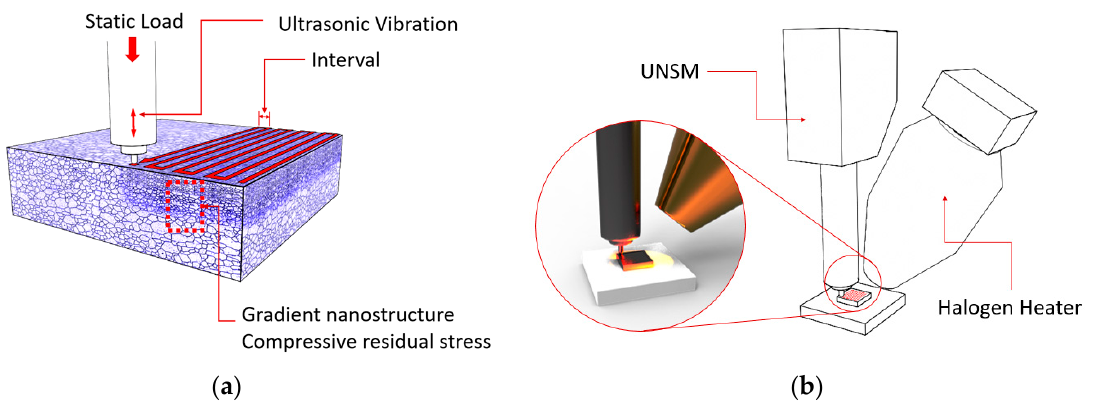
Figure 2. An illustration ultrasonic nanocrystal surface modification (UNSM) treatment showing the modified surface and subsurface of the sample ( a ) and the application of a heat by halogen lamp ( b ). Table 2. UNSM treatment parameters.